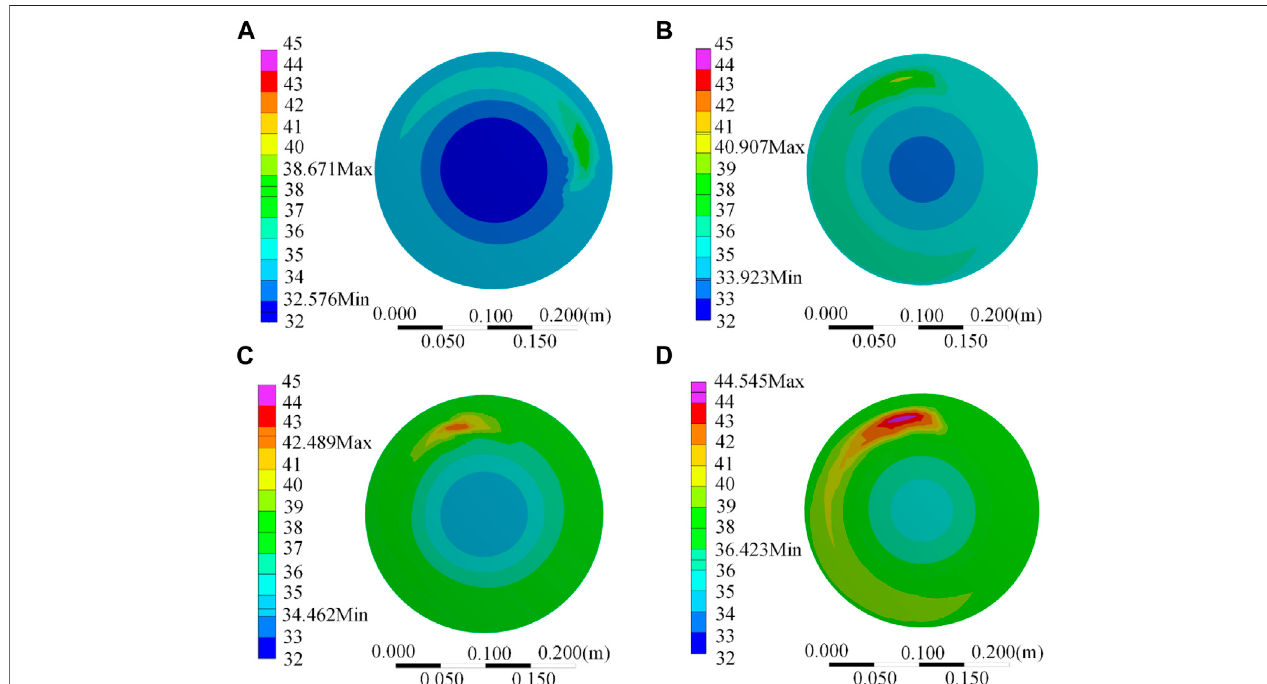
FIGURE5| Distributionofthetemperature fi eldontheliquidmetallapping-polishingplatewithrespecttothedifferentpressuresinsimulation. (A) P=6KPa, (B) P=9 KPa, (C) P=12 KPa, (D) P=15 KPa.